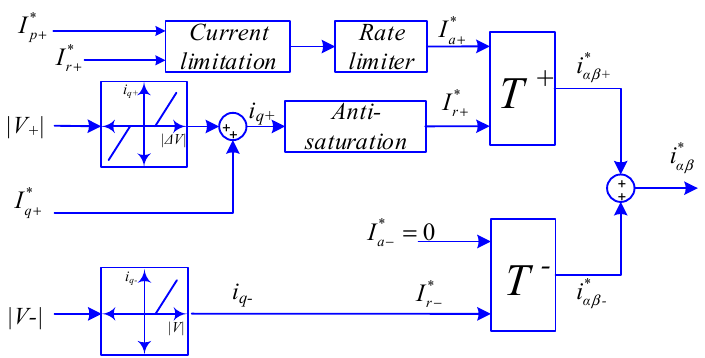
Figure 1. Schematic grid connected converter.